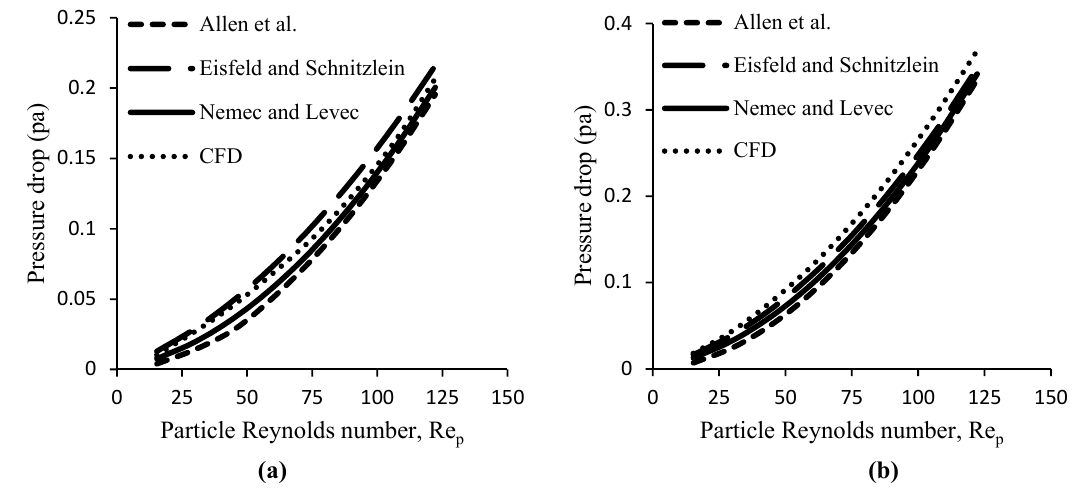
Fig. 5. Comparison of CFD pressure drop with empirical correlations for the packed bed with cylindrical particles in laminar flow: a) N=4.17 and b) N=9.39.